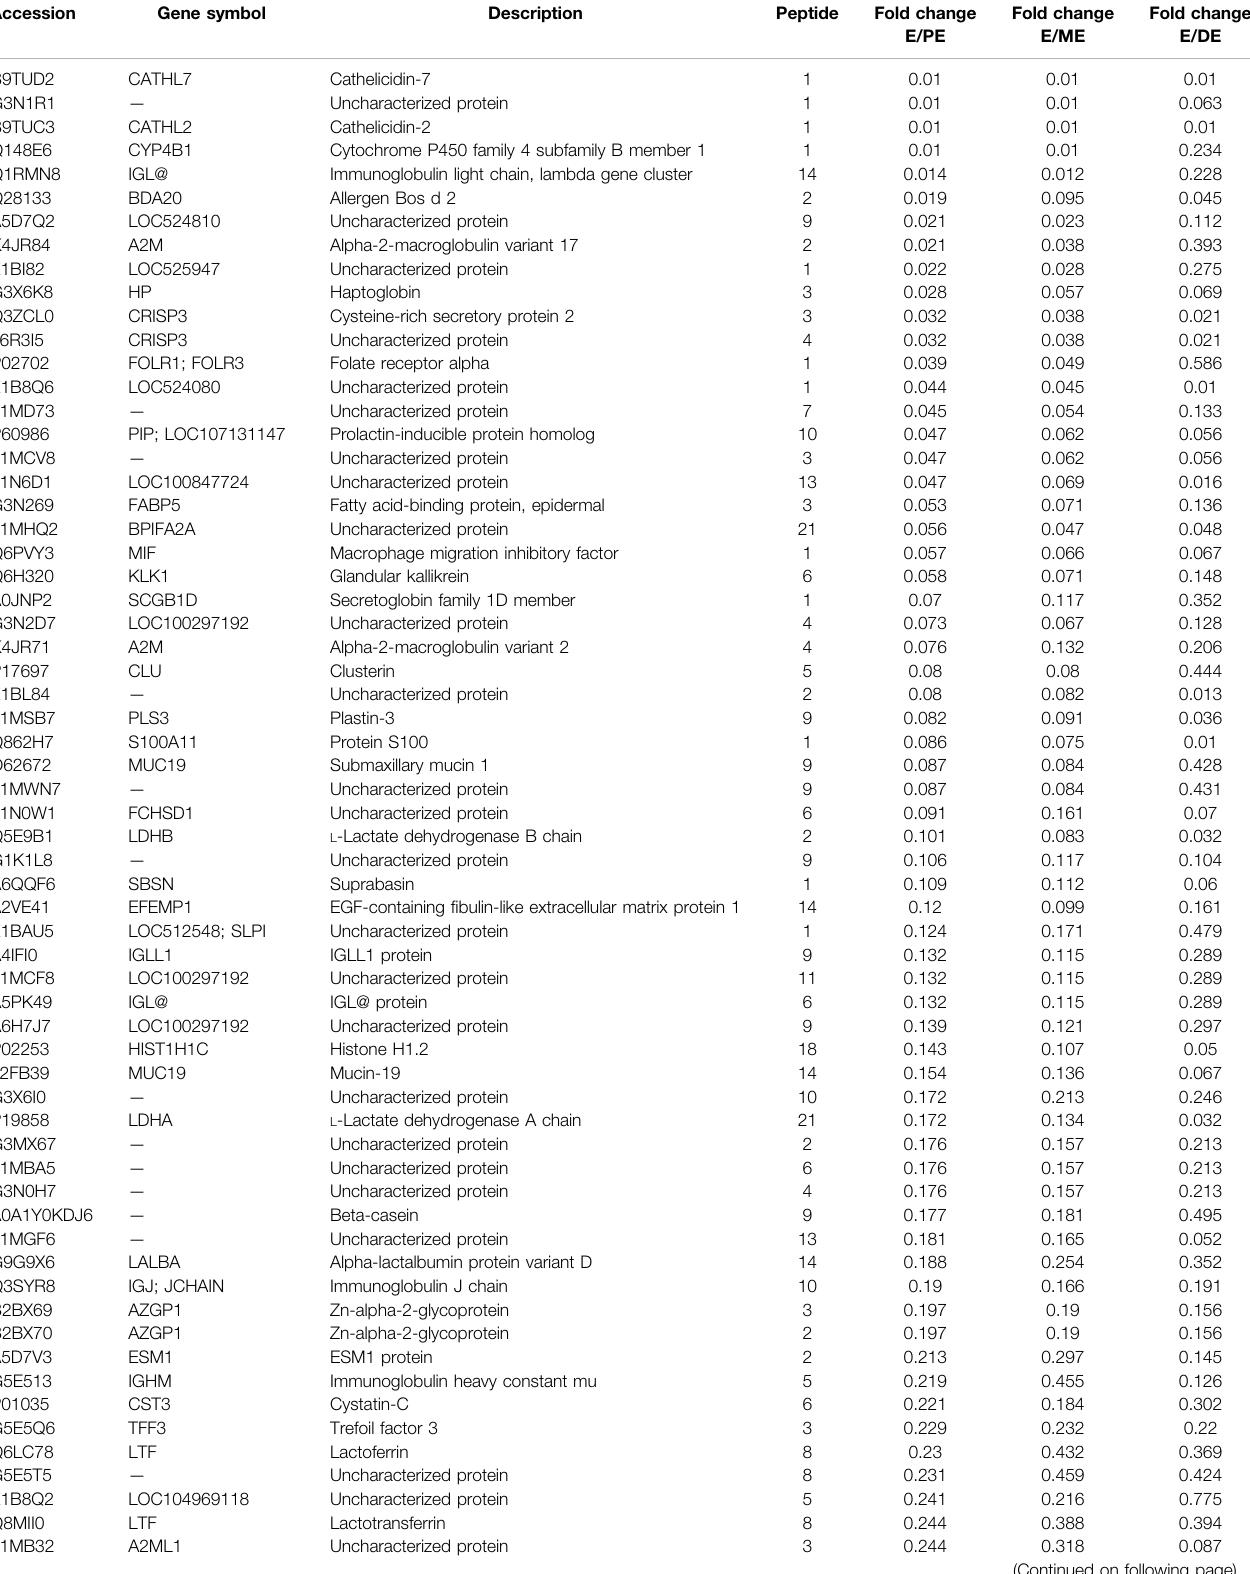
TABLE 5 | List of downregulated proteins during estrus (E) vs. proestrus (PE), metestrus (ME), and diestrus (DE) stages using TMT-LC-MS/MS analysis. Accession Gene